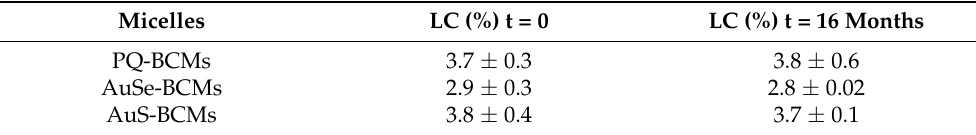
Table 2. Loading content of PQ-BCMs, AuSe-BCMs, and AuS-BCMs immediately after the prepara- tion of the micelles (t = 0) and after 16 months (t = 16